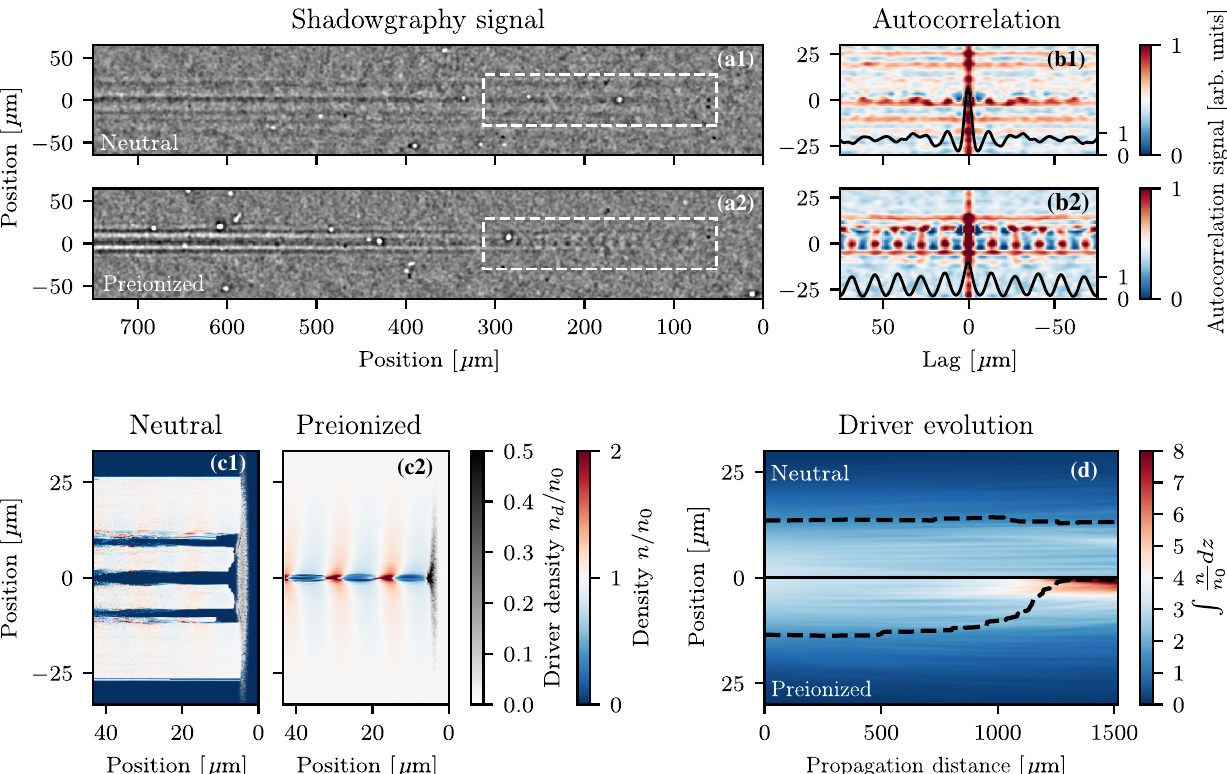
FIG. 3. Electron-driven plasma waves with blocked laser. Top : (a) Shadowgrams of the second jet for neutral and preionized hydrogen gas. The drive bunch propagates from left to right. (b) Row-wise autocorrelations within the region of interest (dashed rectangle). The graphs in (b) are the horizontal lineouts at vertical zero. The transverse modulation in the neutral case can only be attributed to ionization from the electron beam. The autocorrelation (b1) shows no indication of a longitudinal signal modulation that would be generated by a plasma wave. However, the preionized case (a2) shows a weak, but visible periodical longitudinal modulation which is caused by a plasma wave driven by the electron beam. This modulation is clearly visible in the autocorrelation (b2). Bottom : Full 3D simulations of the interaction. (c) Charge densities of the background plasma electrons (blue-red color scale) along with the driver (gray color scale). The regions in (c1) where the electron density is zero correspond to nonionized gas. (d) Evolution of the transverse (longitudinally integrated) driver density for both cases, along with their half width at half maximum (HWHM, dashed line). The driver in the preionized case self-focuses much faster and drives a stronger plasma wave, even with full blowout of the background electrons. In the neutral case the driver is not able to fully ionize the gas. See Fig. S3 in the Supplemental Material [47] for a close-up of the